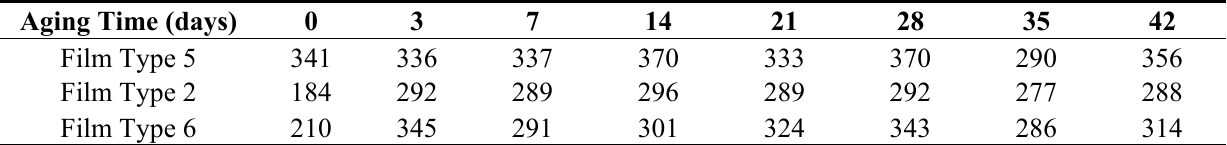
Table A4. modulus of elasticity (unit: ksi) vs. aging time at a 100 °C aging temperature for films with the same layer thickness, but various film thicknesses.